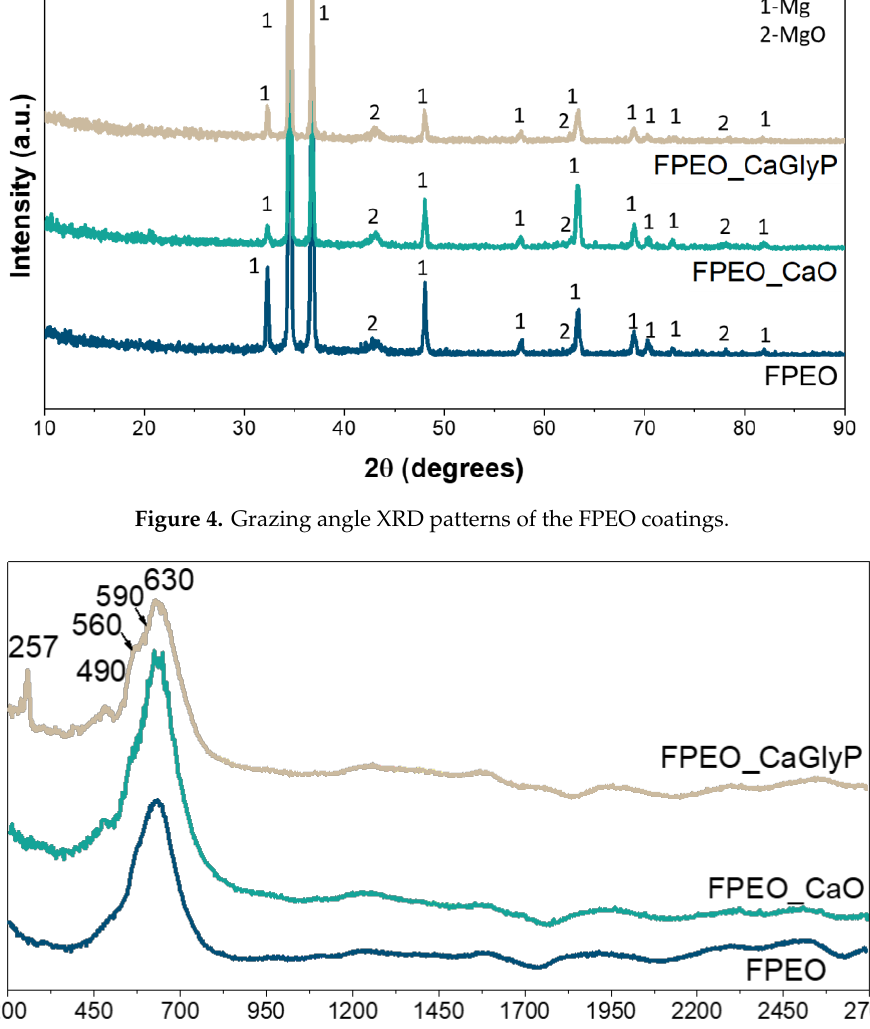
Figure 5. Raman spectra of the flash-PEO coatings.